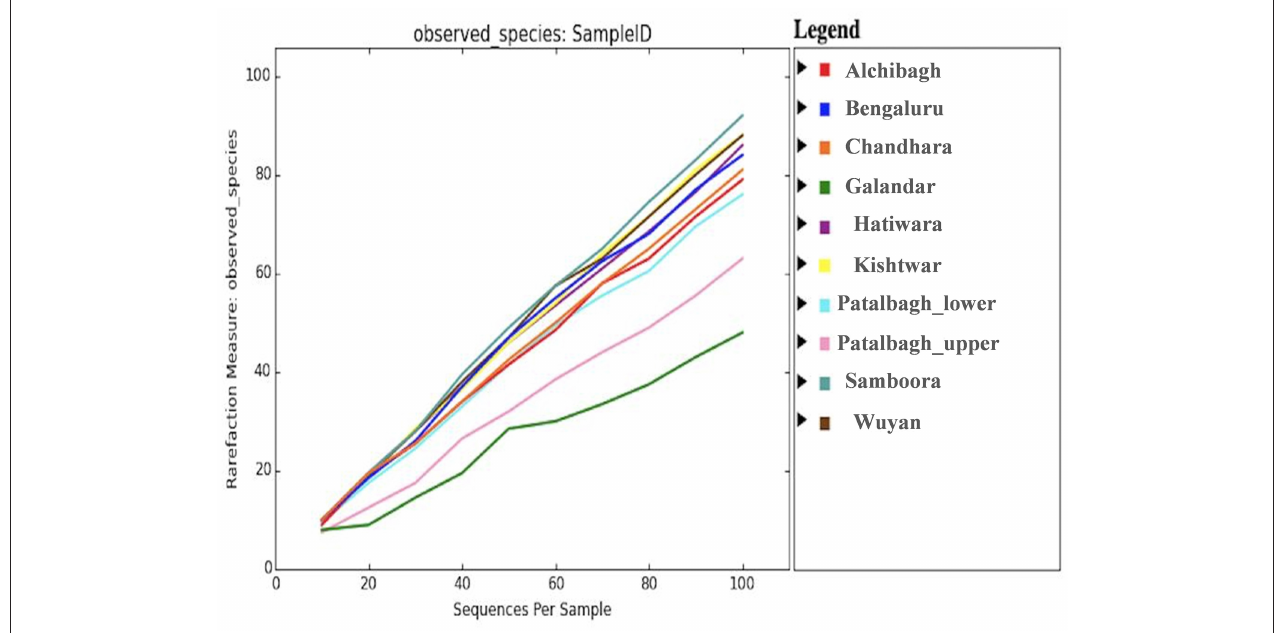
FIGURE 7 | Rarefaction curve representing the bacterial diversity across 10 samples where in Samboora is more diverse and Galandar is least diverse as represented by the number of species observed as per plot.